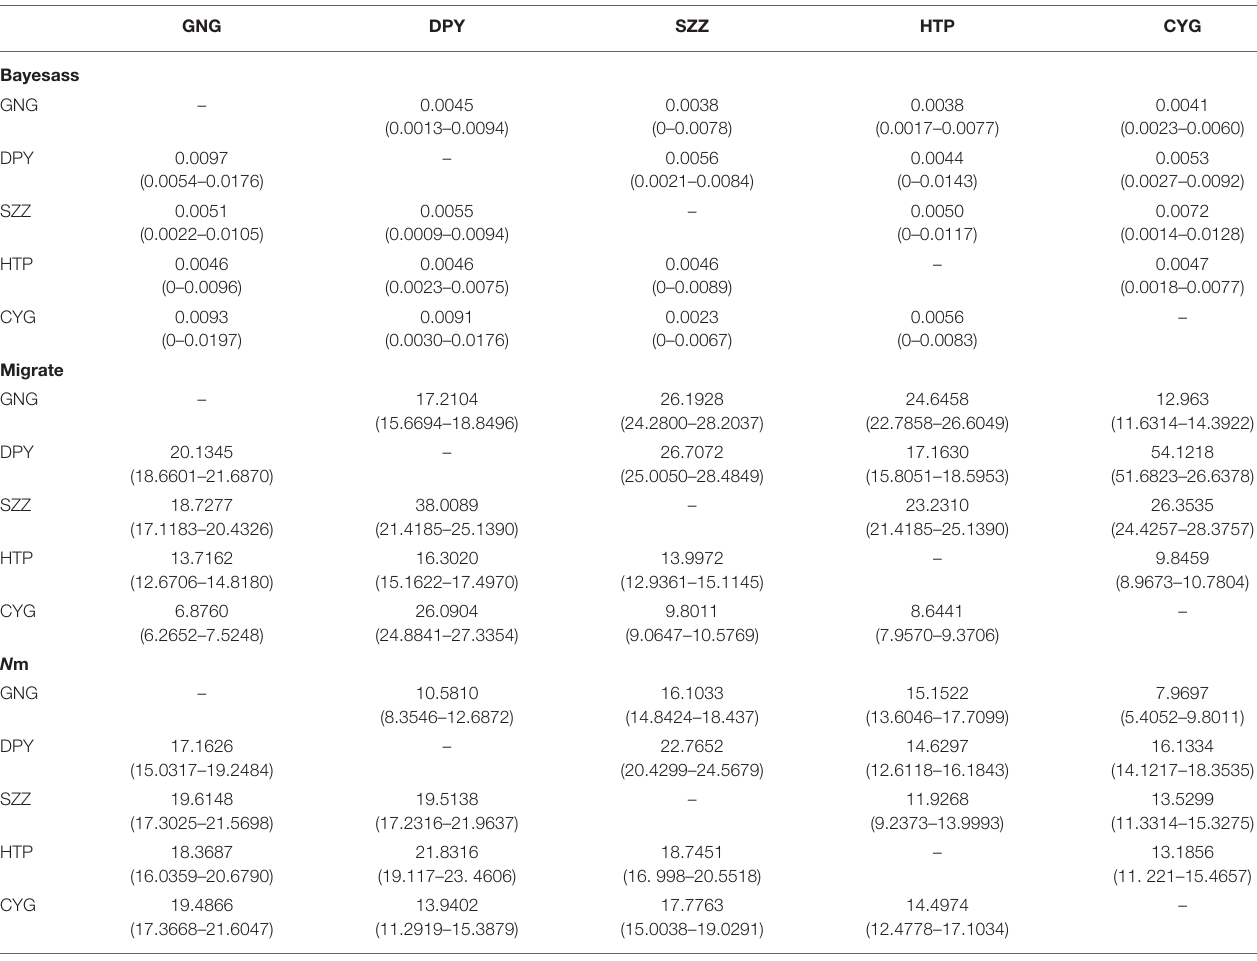
95% confidence intervals are presented in parentheses.